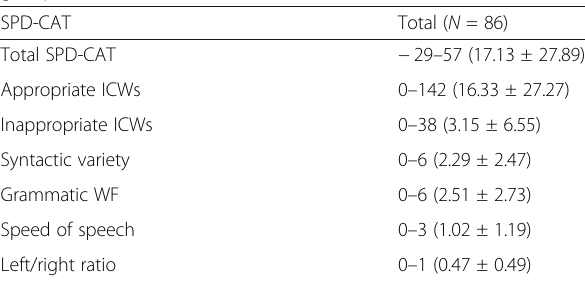
Table 6 MRI lesion volume (LV), side and site among study group